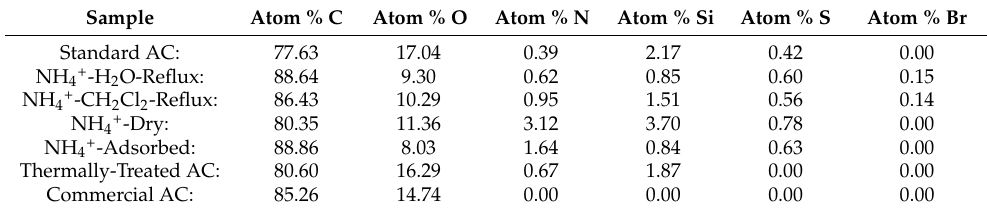
Table 1. XPS atom percent surface composition of activated carbon.